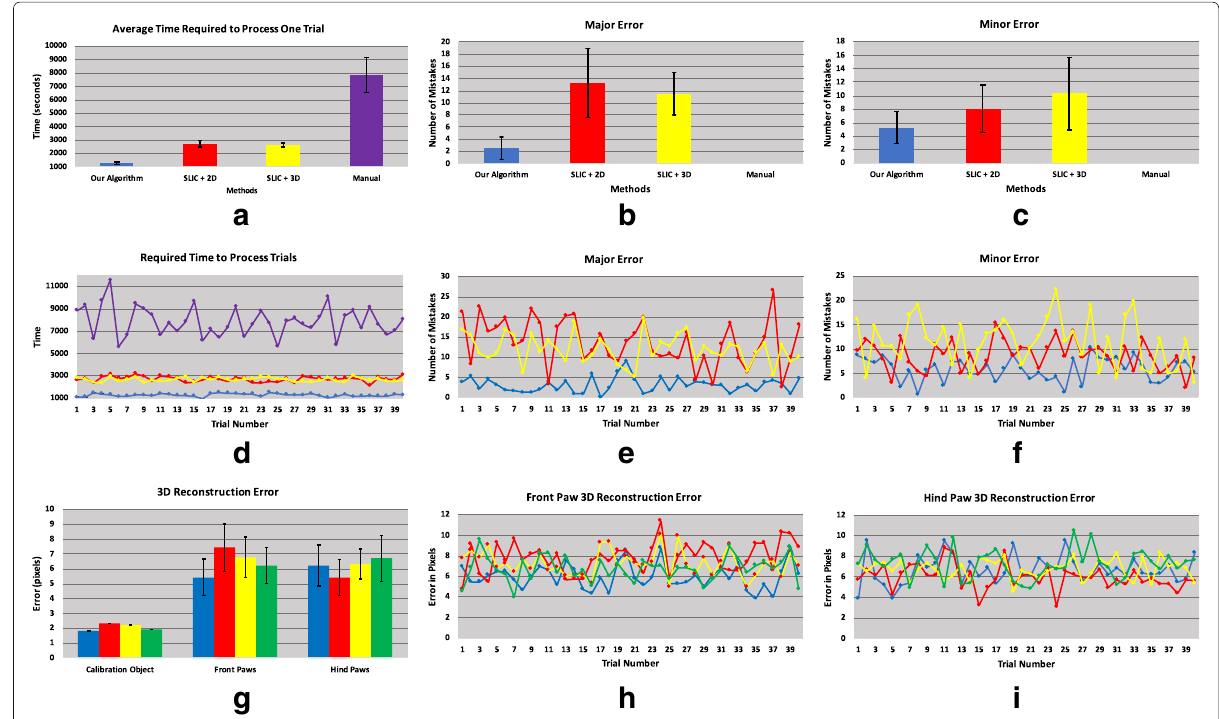
Fig. 7 The error plots. Panels a , b , and c show a comparison between our proposed algorithm with four other methods for the dataset (4 cameras × 2 trials each animal × 5 mice = 40 trials). These three methods are SLIC with 2D KF, “SLIC+2D”; SLIC with 3D KF, “SLIC+3D;” and MT. Panel a shows the required time by different methods to process one trial, 1000 frames from each of the four cameras. Panels b and c show the average number of “critical mistakes” per trials that software needed user intervention to label paws correctly after that mistake (major error) and the average number of mistakes per trials that the software did not need any user intervention to recover from the mistake (minor error), respectively. While panels d , e , and f show the results of each trial for the measures presented in panels a , b , and c , respectively. The colors show the results for the methods presented in a , b , and c . 3D reconstruction error, Section 4.4, is shown in g . It shows the error for the calibration object, front paw, and hind paw in the four cameras. The blue, red, yellow, and green colors in g show the results of camera 1, 2, 3, and 4. The plots h and i show the 3D reconstruction error of different trials for front and hind paws,